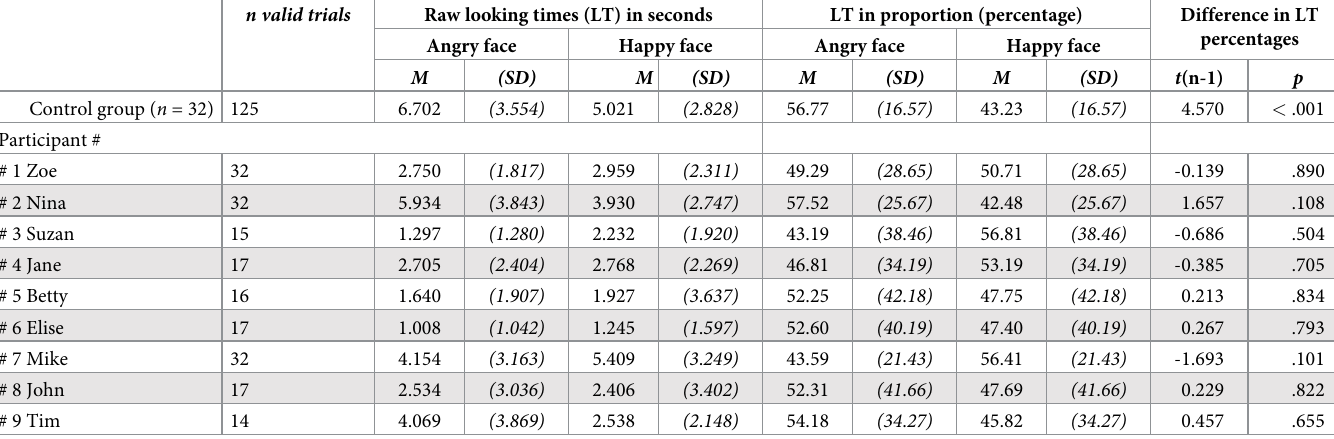
Table 8. Mean (and SD ) looking times (raw and percentage) at each of the two emotional expressions (i.e., angry and happy faces) of the control group and the nine PIMD participants recorded during the repeated presentation (four 20-second trials) of pairs of male and female happy and angry faces. n valid